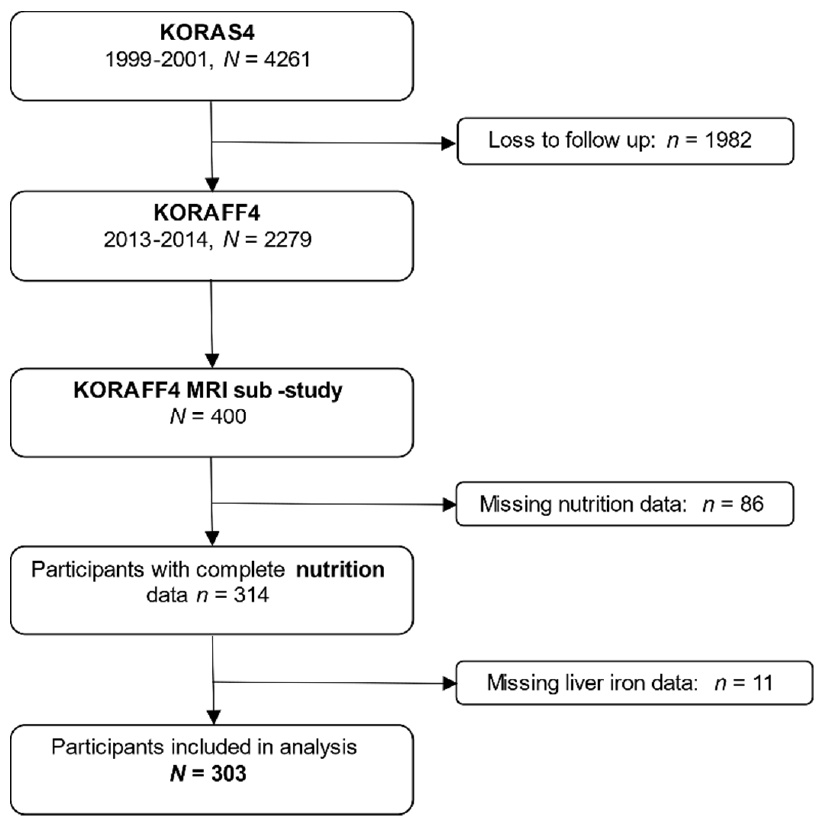
Figure 1. Participant flow chart. Among 400 individuals who underwent the MRI-examination, a total of 303 were included in the analysis.